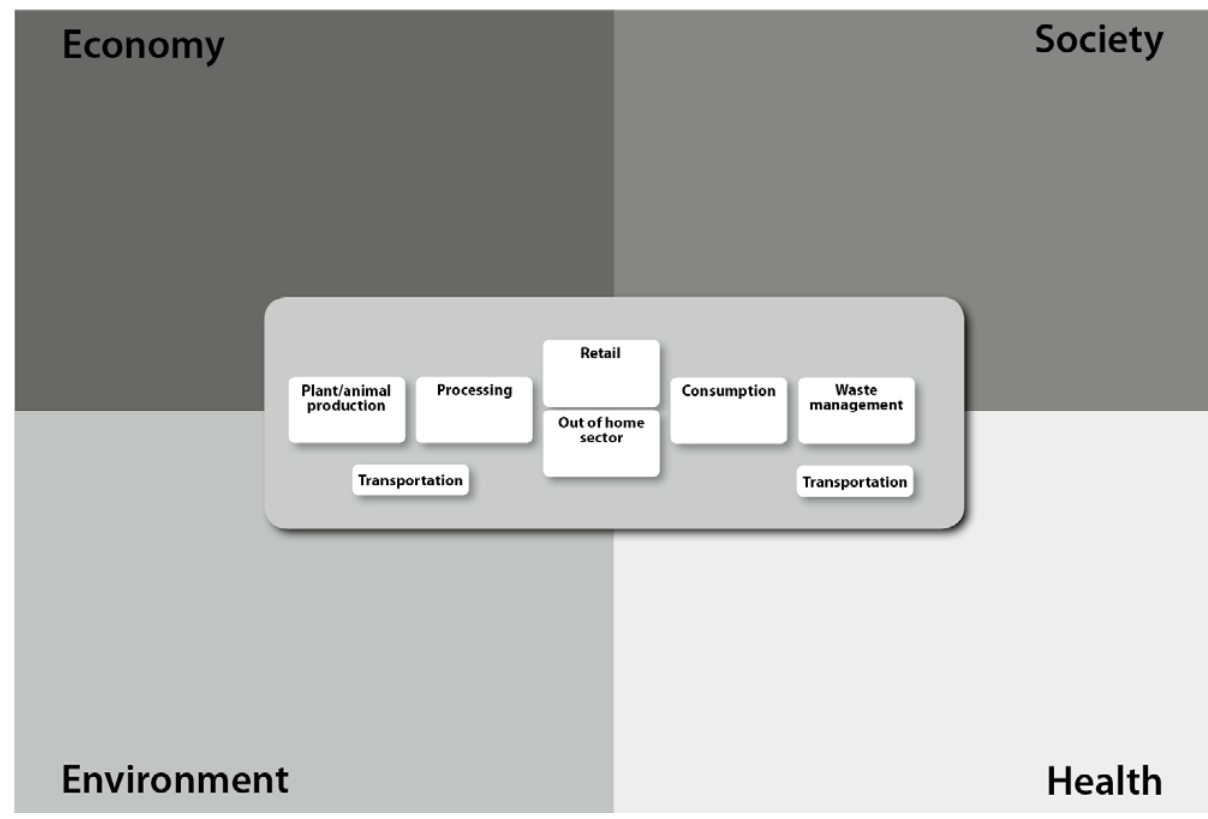
Figure 1. The nutrition ecological approach - the four dimensions of nutrition and the complete food supply chain are taken into